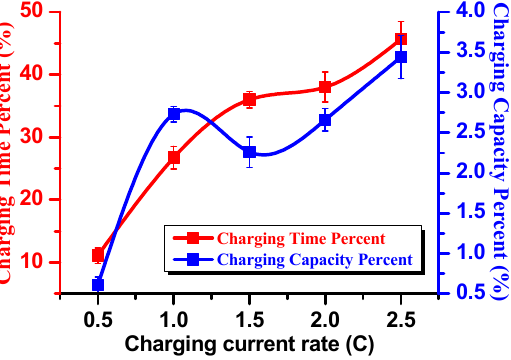
Figure 1. Charging capacity percentage and charging time percentage of CV stage in CC/CV (constant current/constant voltage) strategy at different charging current rates.